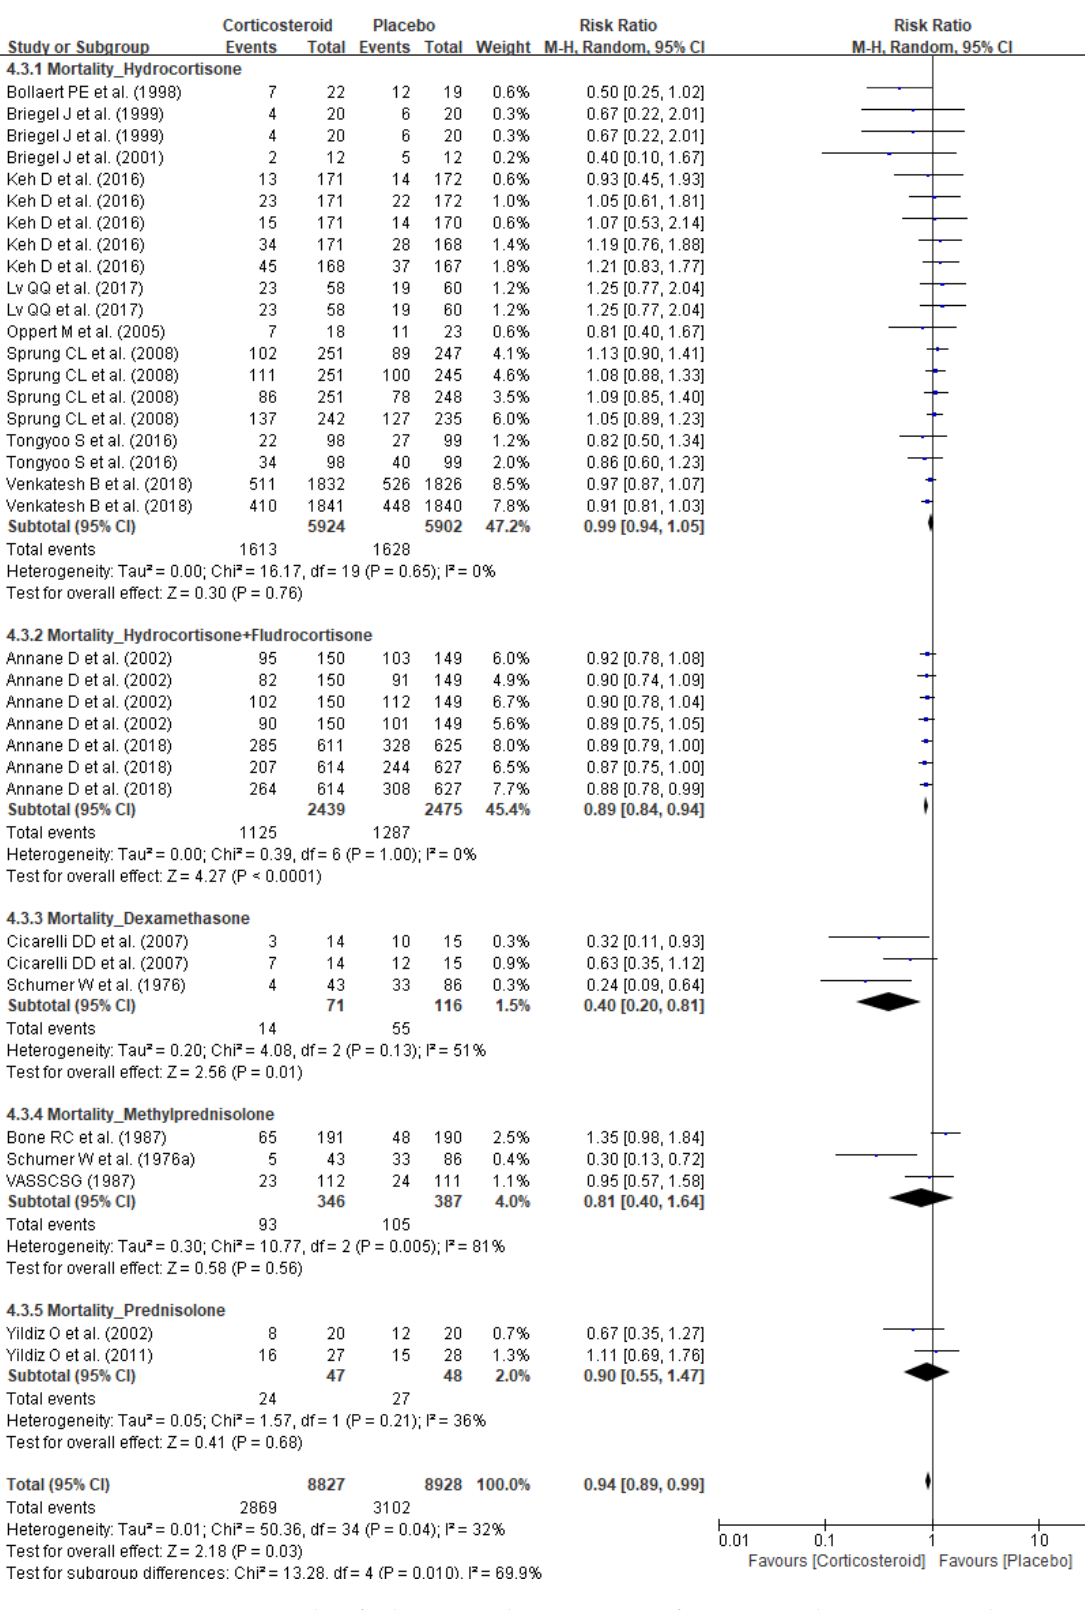
Figure 5. Forest plot of subgroup analysis on impact of corticosteroid agents on mortality.